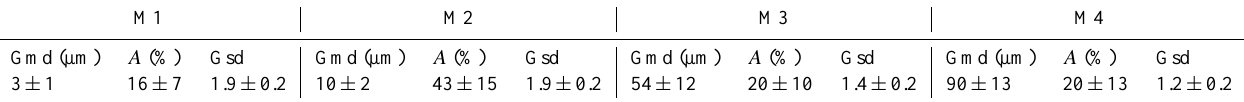
Table 1. Averaged parameters (geometric mean diameter (Gmd), amplitude ( A ) and geometric standard deviation (Gsd)) of the four lognor- mal modes (components) identified from measured size distributions of sediment samples (B6 and G10